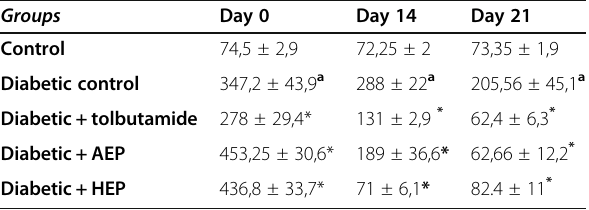
Table 1 Effect of peel extracts of I. Wombolu on the glucose levels (mg/dl) after 21 days of treatment